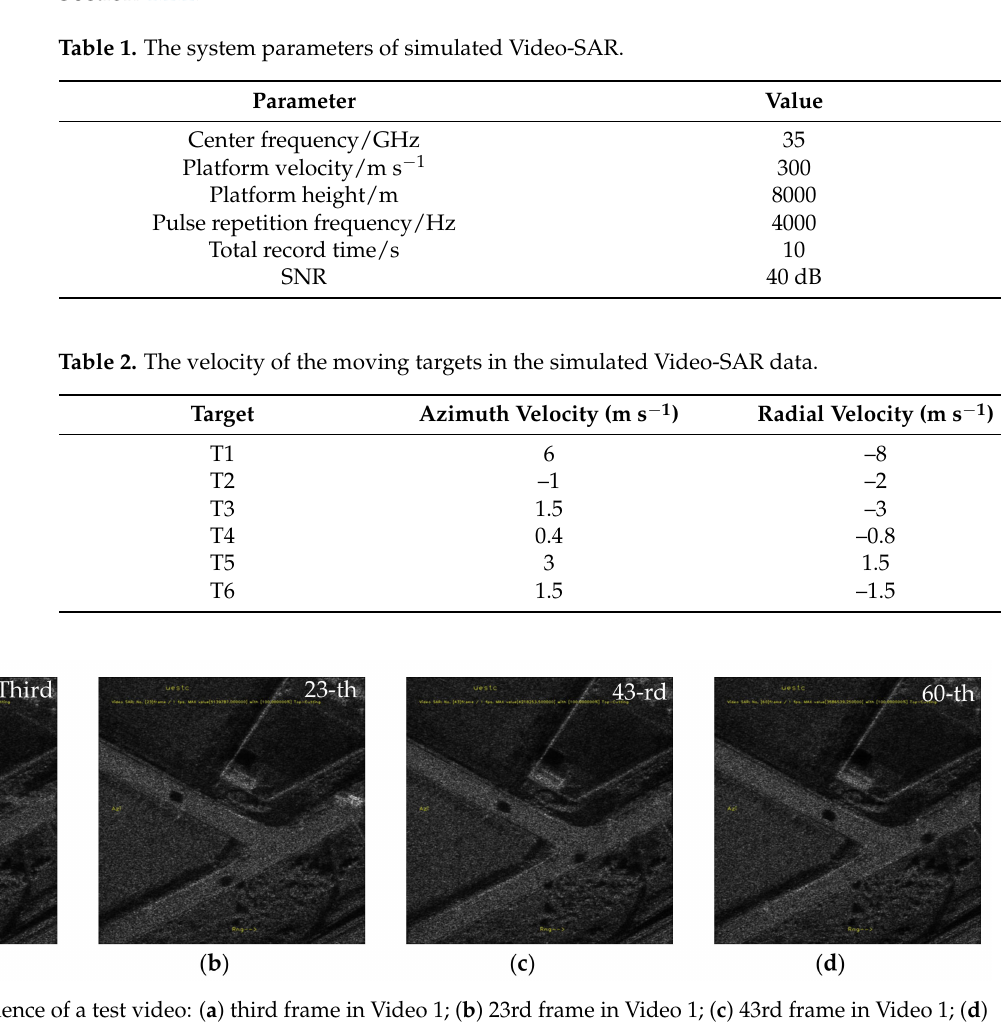
Figure 11. Image sequence of a test video: ( a ) third frame in Video 1; ( b ) 23rd frame in Video 1; ( c ) 43rd frame in Video 1; ( d ) 60th frame in Video